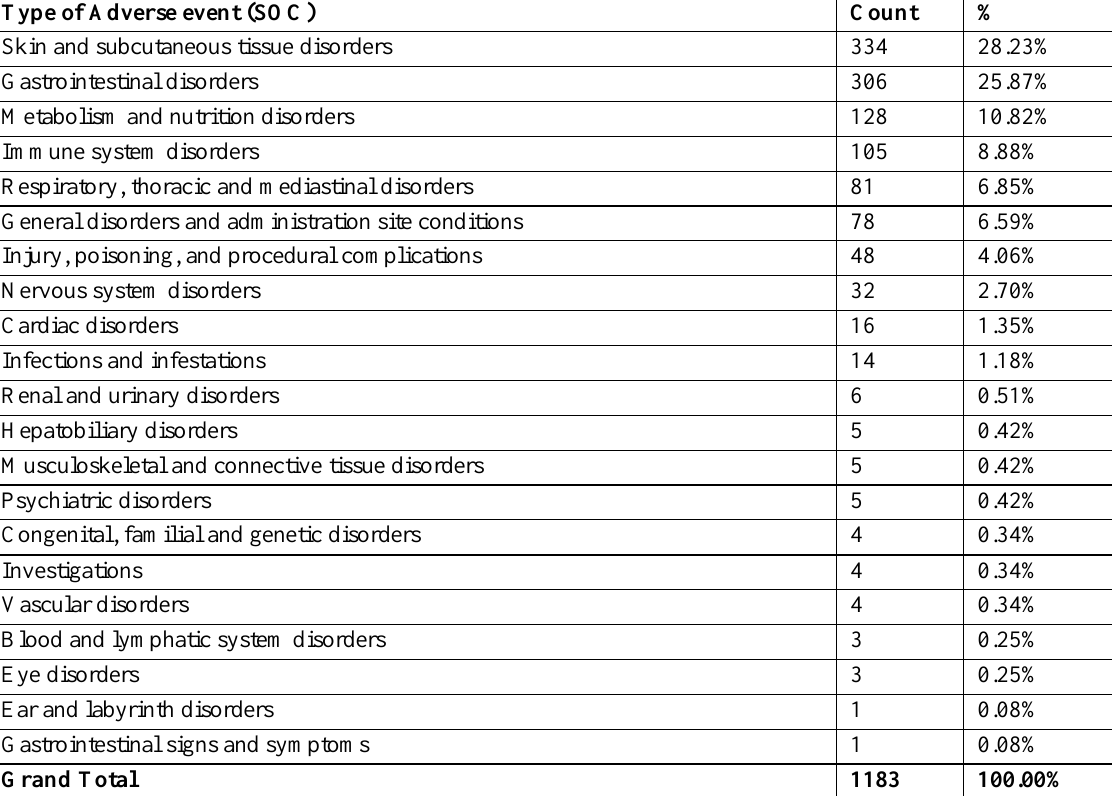
Table 7. Adverse drug event resulted from medication error classified by system organ class SOC Type of Adverse event